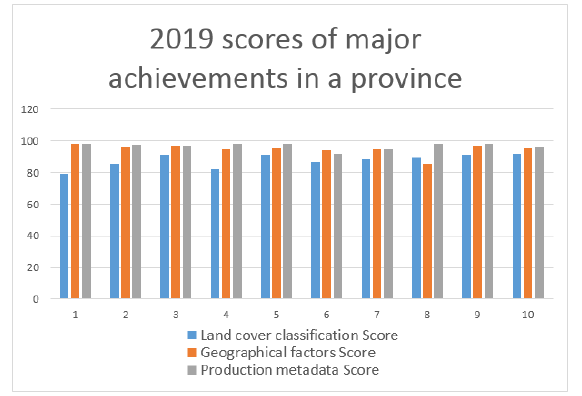
Figure 3. Unit achievement score of a province